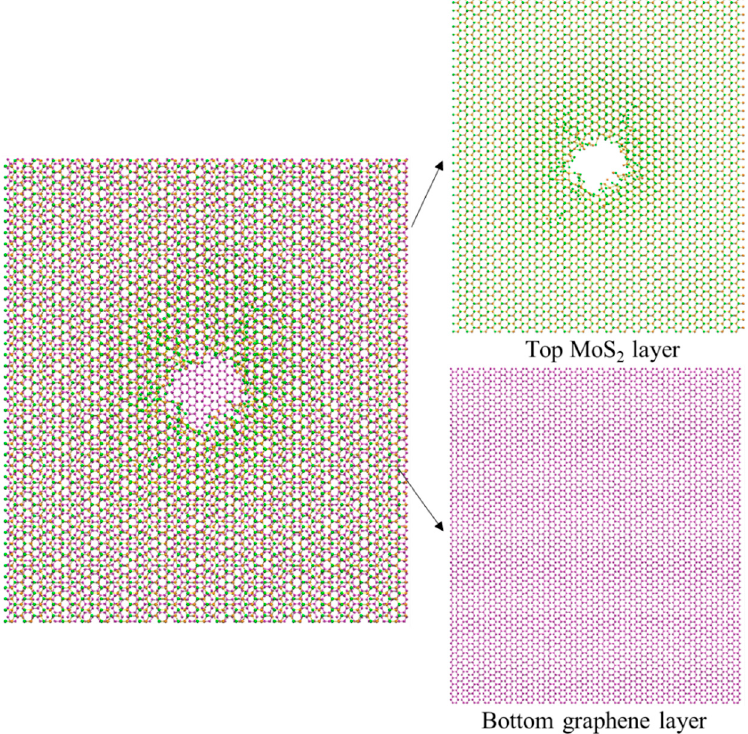
Figure 7. Configurations of the M/G heterostructure under ion irradiation with a parameter pair of 80 eV, 3.18 × 10 15 /cm 2 .